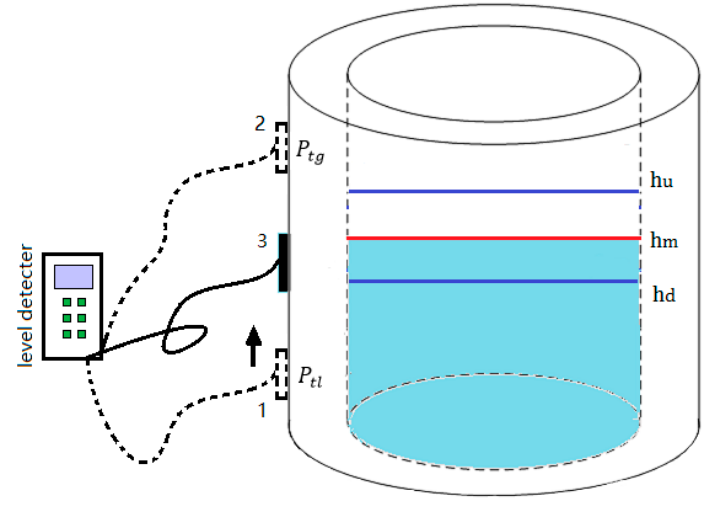
Figure 6. The operating schematic diagram of liquid level measurement in the experiment.